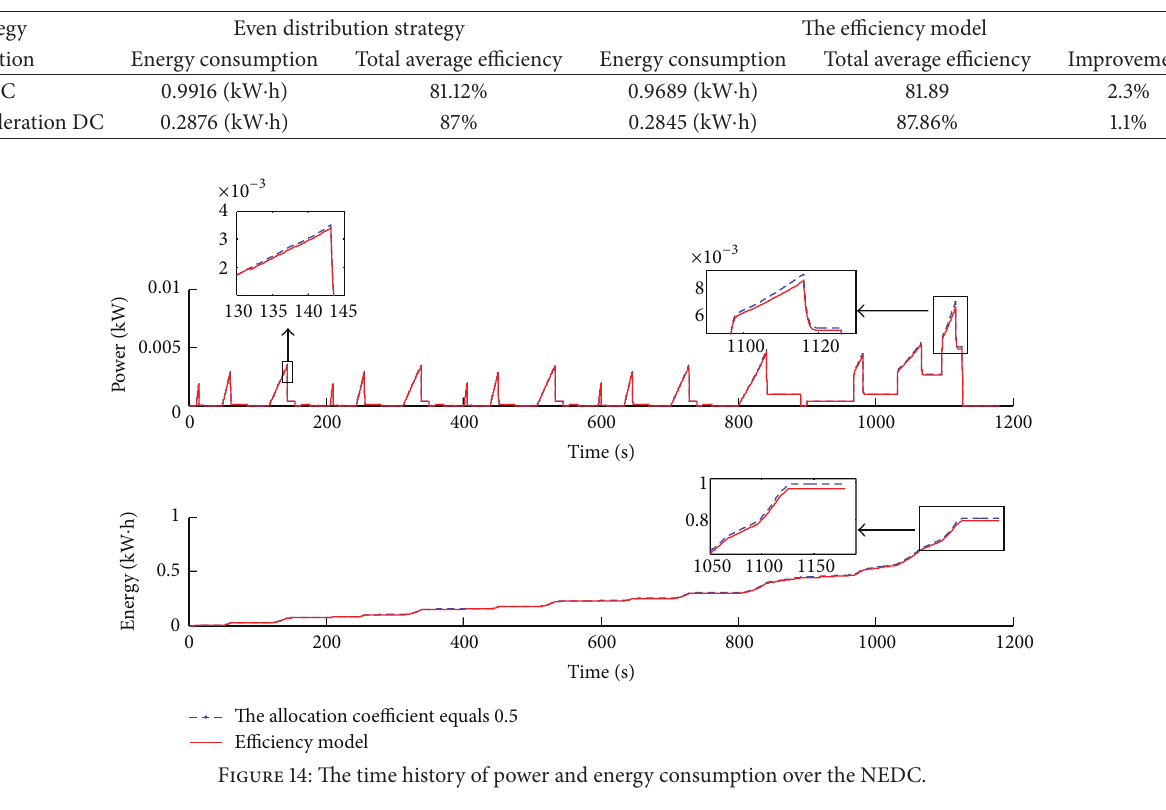
4.2.1. The Road Simulation Parameters. The peak adhesion coefficient at each wheel represents the road adhesion